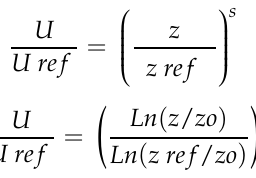
Figure 5. The average temperature performance of the three regions.